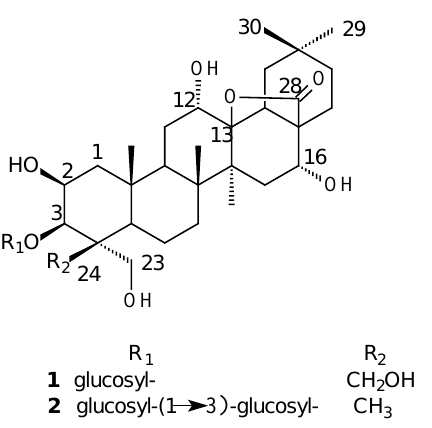
Figure 1 . Structures of compounds 1 and 2